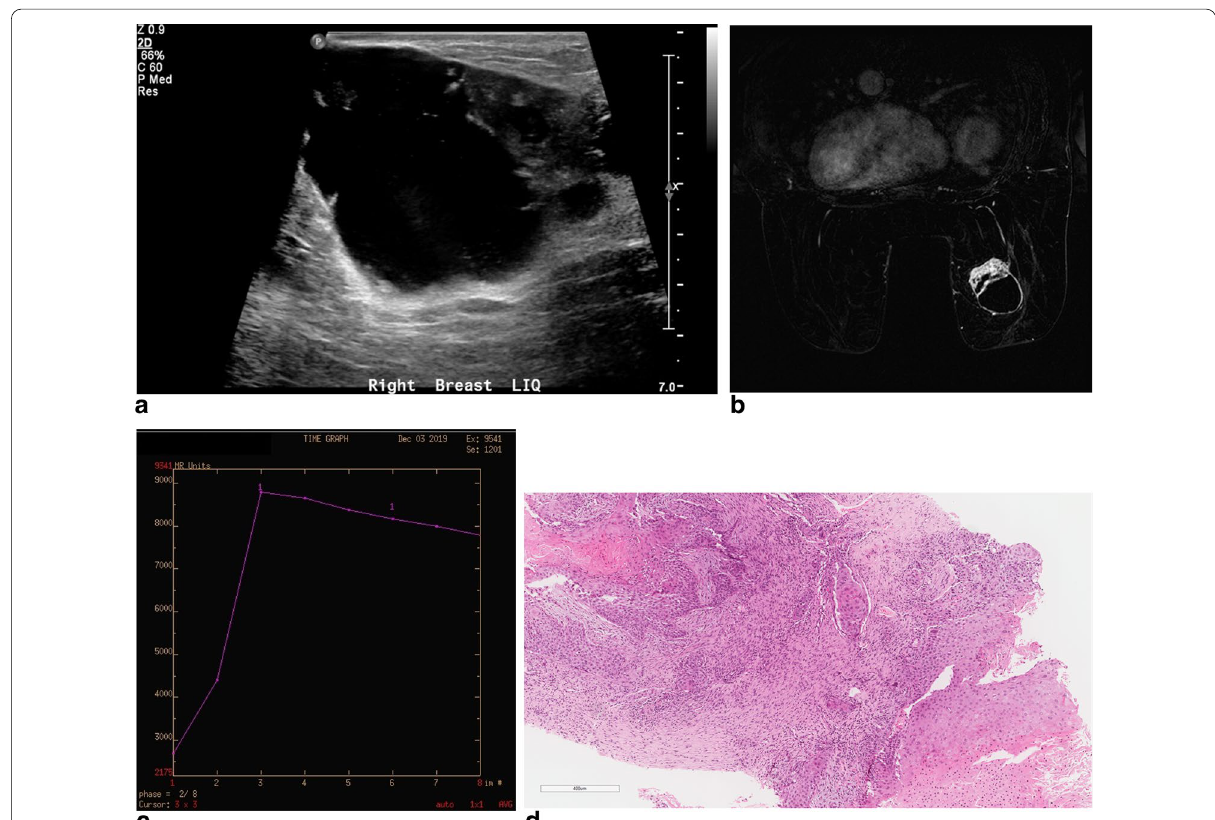
Fig. 1 A right breast mass in a 53-year-old woman with squamous cell carcinoma subtype. a The ultrasound shows a complex mass with cystic and solid component at lower inner quadrant. b , c Shows the MRI in dynamic phase that revealed a rim enhanced mass with washout pattern